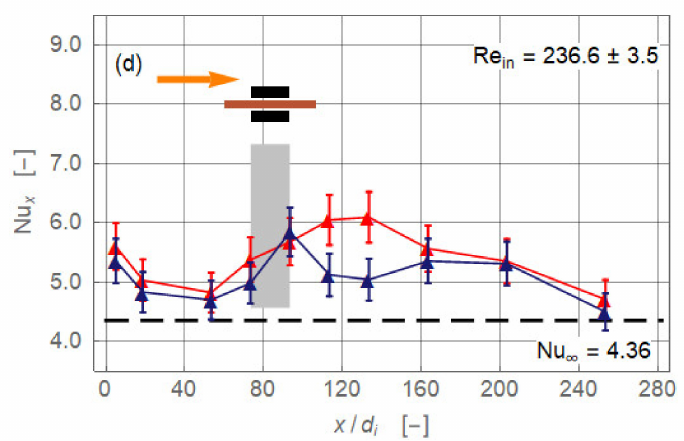
Figure 4. Local Nusselt number along non-dimensional axial coordinate for the magnet configura- tions single magnet below and above and two attracting magnets ( r cl = 34 mm). The plots show ( a ) magnet below pipe, ( b ) magnet above pipe, ( c ) magnets below and above pipe attracting each other, and ( d ) magnets below and above the pipe repulsing each other. Symbols indicate experimental data. Data points connected only to improve visibility. The colours stand for ferronanofluid without magnet(s) (red) and with magnet(s) (dark blue). Orange arrow indicates direction of flow. Black rectangles show length and position of magnet(s) with respect to pipe. Grey bar indicates region of magnet(s) with respect to x/d i